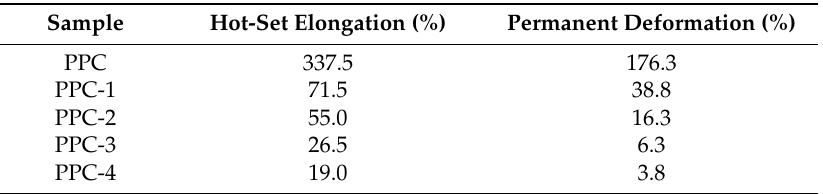
Table 4. The results of the hot-set elongation tests.